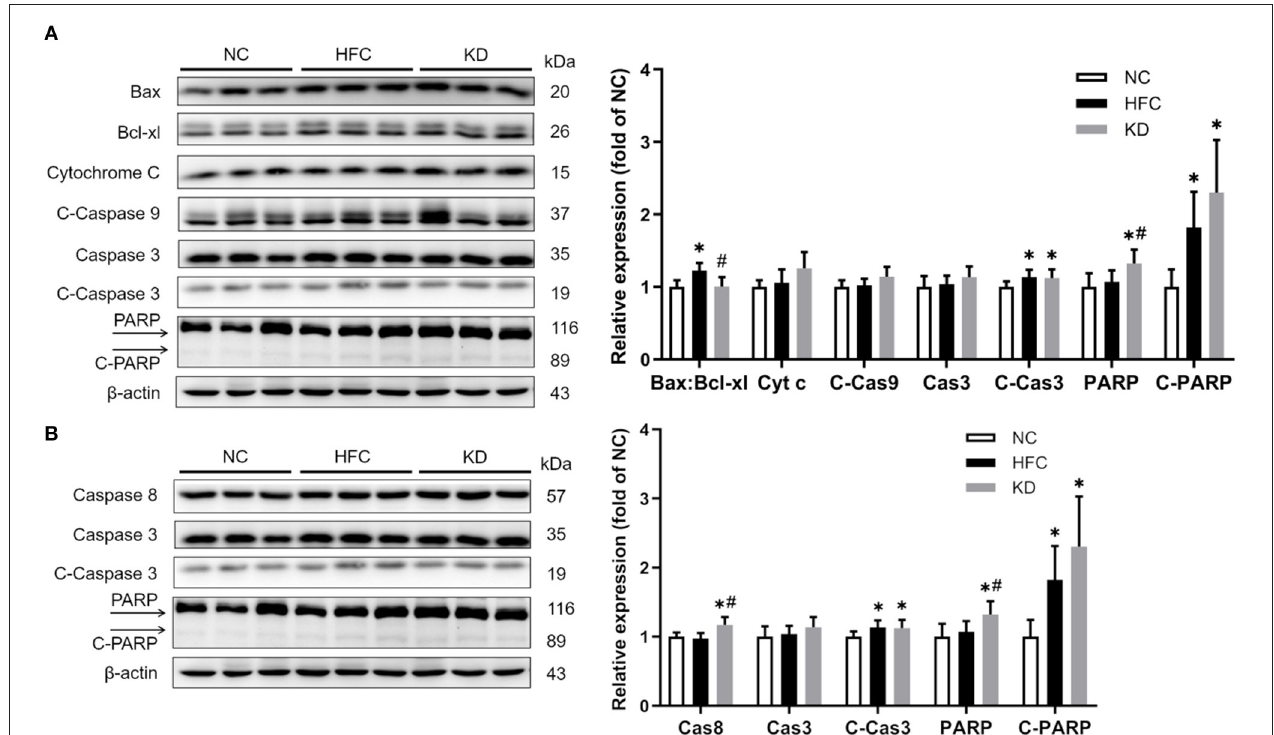
FIGURE 7 | Effects of a high-fat and high-cholesterol diet and a ketogenic diet on testicular (A) intrinsic and (B) extrinsic apoptosis pathway regulators, including the ratio of Bax:Bcl-xl and the levels of cytochrome c (Cyt c), caspase 3 (Cas3), cleaved-caspase 3 (C-Cas3), caspase 8 (Cas8), cleaved-caspase 9 (C-Cas9), PARP, and cleaved-PARP (C-PARP) in male mice. Protein expressions in each group were measured using western blot analysis, and β -actin was used for normalization. Data are expressed as the mean ± SD. * p < 0.05, compared with the NC group; # p < 0.05, compared with the HFC group. NC, normal diet; HFC, high-fat and high-cholesterol diet; KD, HFC diet changed to MCT-based ketogenic diet.